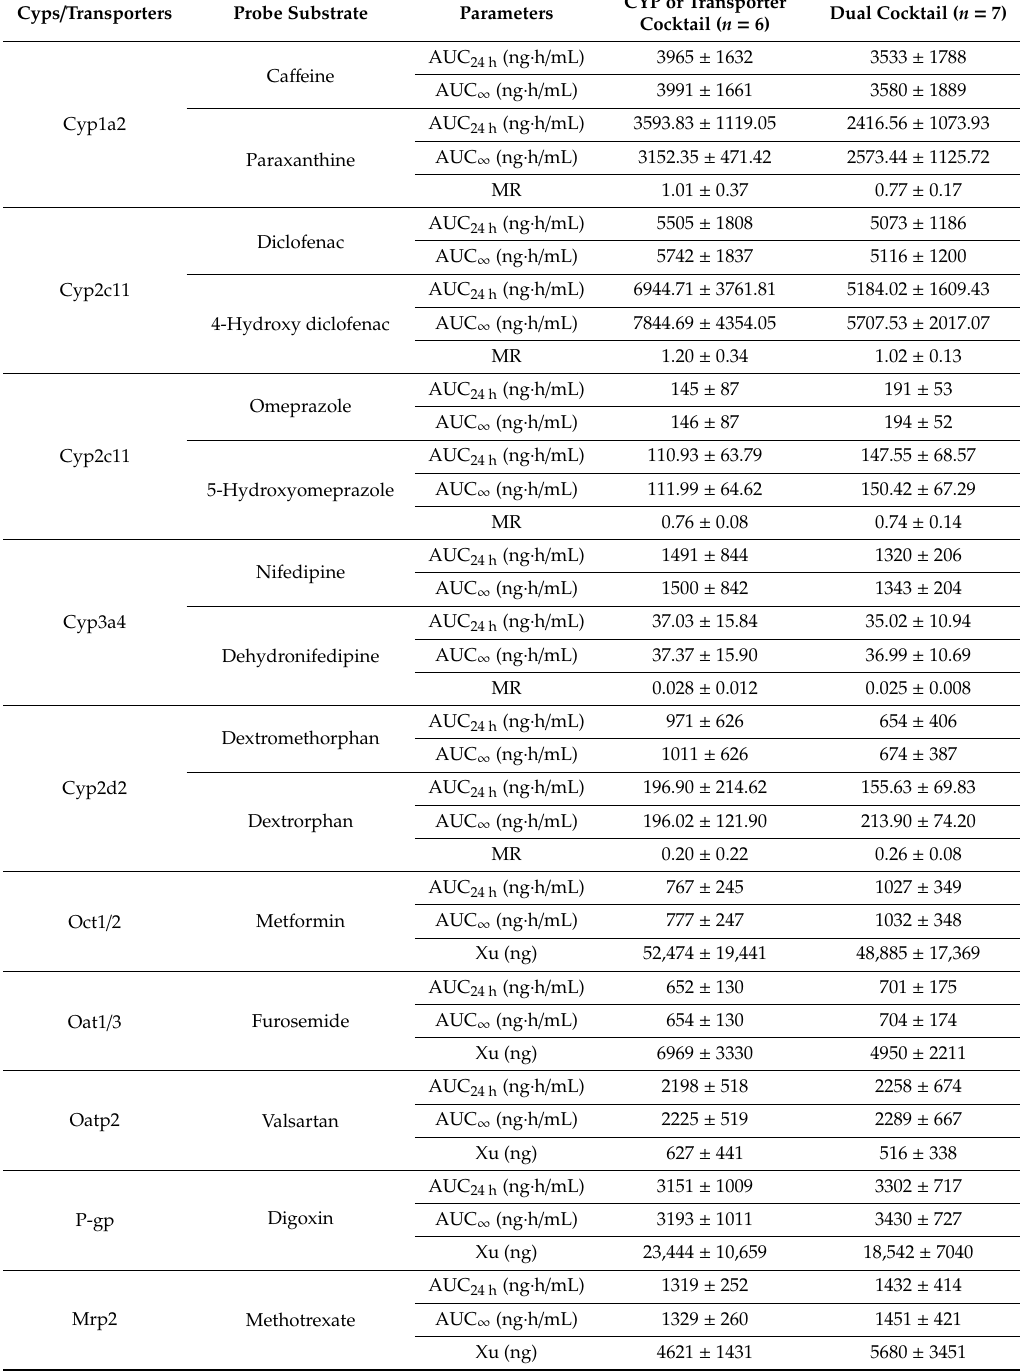
Table 7. The comparison of pharmacokinetic parameters between the dual cocktail and CYP or transporter cocktail